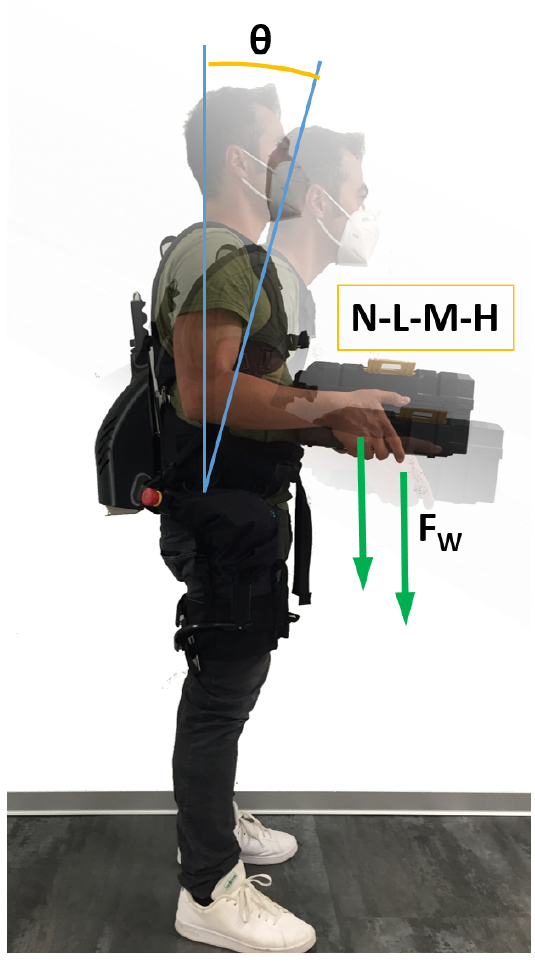
Figure 3. Experimental protocol